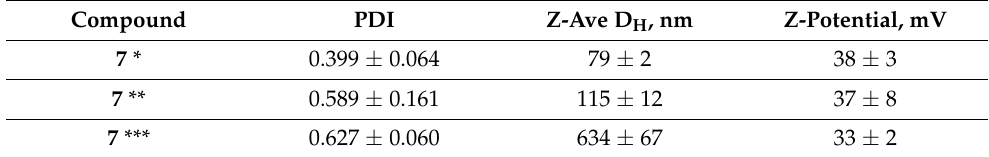
Table 1. Values of polydispersity index (PDI), Z -average diameter, zeta-potential of nanoparti- cles formed by 1,4-DHP amphiphile 7 obtained by DLS measurements. The PDI value describes polydispersity of the sample; the Z -average diameter represents the average hydrodynamic diam- eter of all nanoparticles in the sample; zeta-potential gives information about the surface charge of